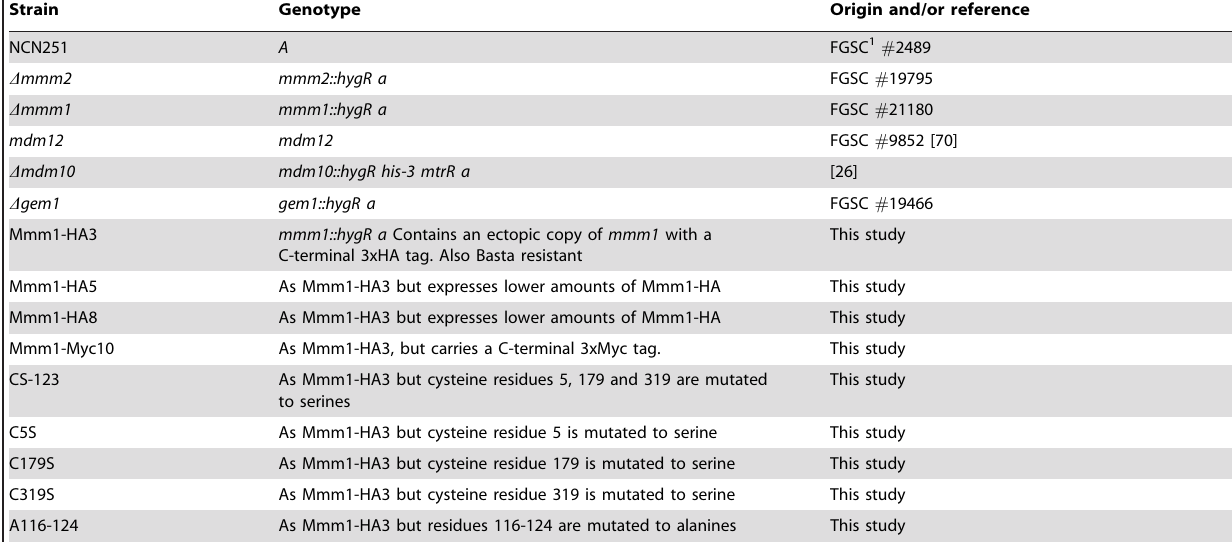
Table 1. Strains used in this